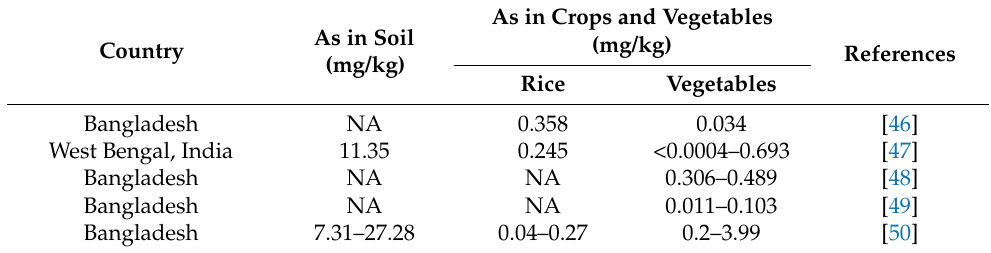
Table 1. Concentrations of As in soil, crops, and vegetables cultivated in West Bengal, India, and neighbouring countries (adapted from Santra et al., 2013 [45]). As in Crops and Vegetables As in Soil Country (mg/kg)